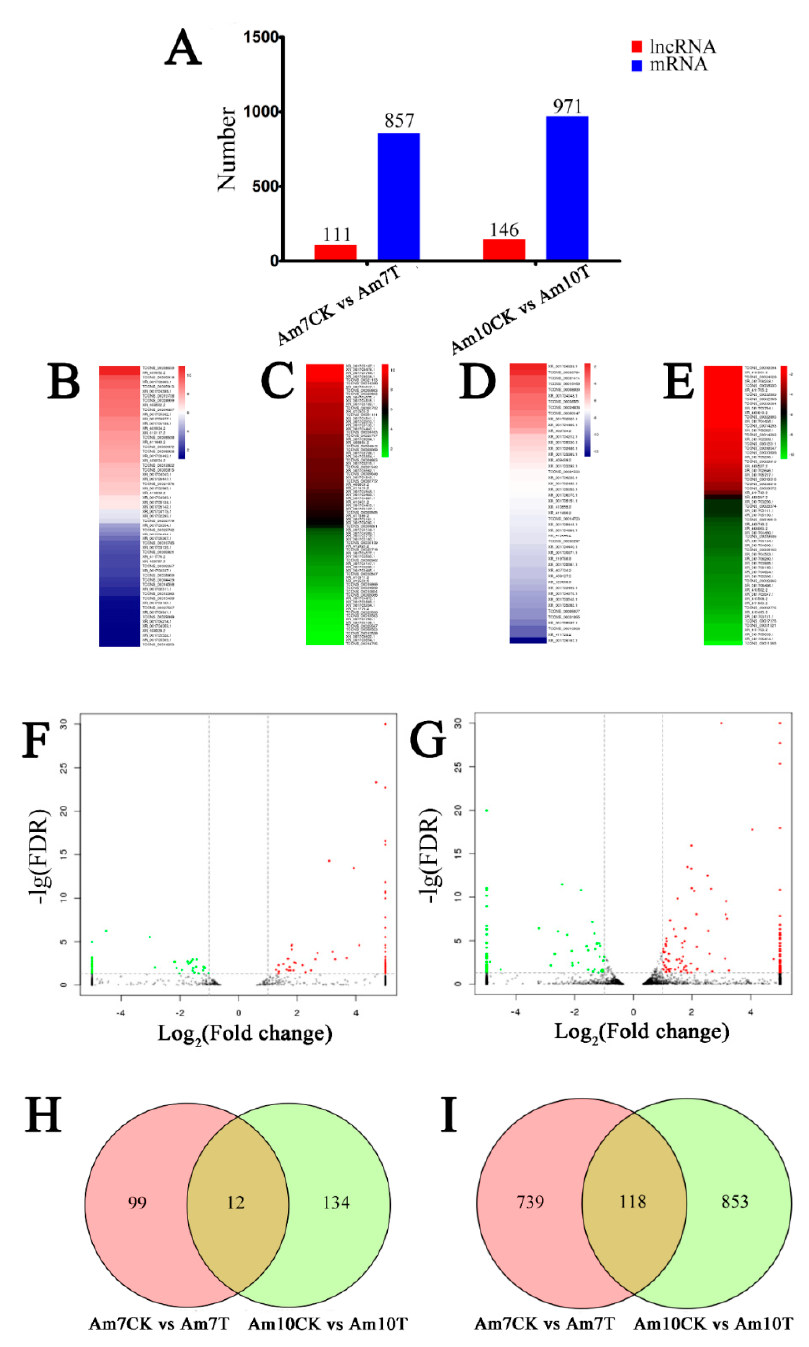
Figure 3. Di ff erential expression patterns of A. m. ligustica lncRNAs and mRNAs in N. ceranae -infected midguts compared with normal midguts. ( A ) number of di ff erentially expressed lncRNAs (DElncRNAs) and di ff erentially expressed genes (DEGs). ( B , C ) expression clustering of up- and down-regulated lncRNAs in Am7CK vs. Am7T. ( D , E ) expression clustering of up- and down-regulated lncRNAs in Am10CK vs. Am10T. ( F , G ) volcano plots of DEGs in Am7CK vs. Am7T and Am10CK vs. Am10T. ( H ) venn diagram of DElncRNAs in Am7CK vs. Am7T and Am10CK vs. Am10T. ( I ) venn diagram of DEGs in Am7CK vs. Am7T and Am10CK vs.